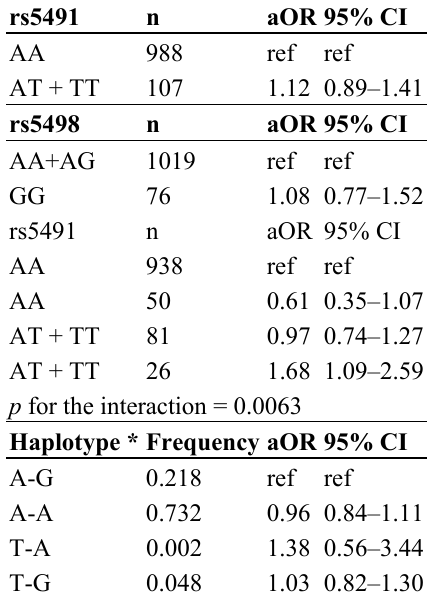
Table 2. The association between ICAM1 polymorphism and